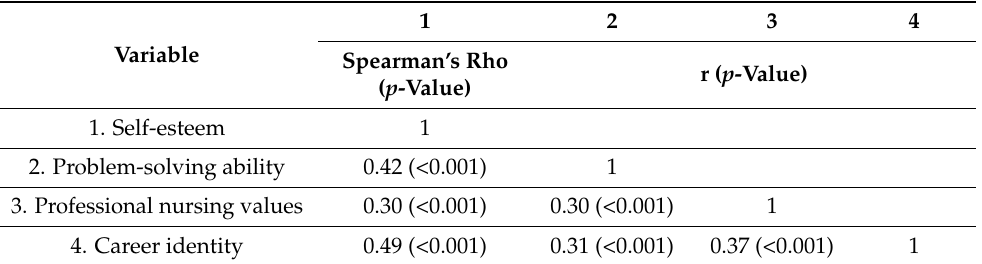
Table 4. Correlations between variables ( N = 140).